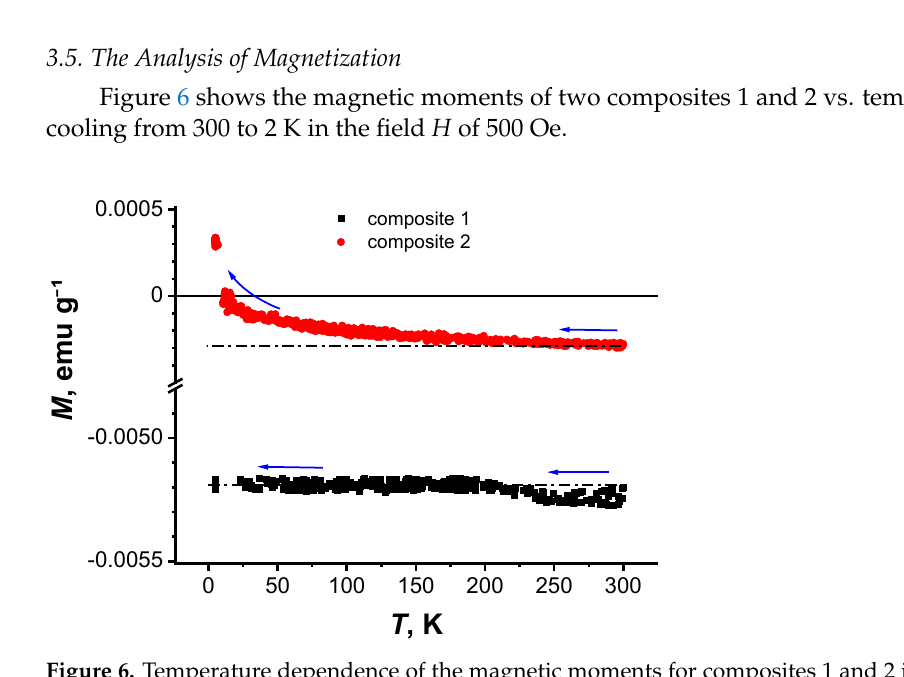
Figure 6. Temperature dependence of the magnetic moments for composites 1 and 2 in cooling at H = 500 Oe.